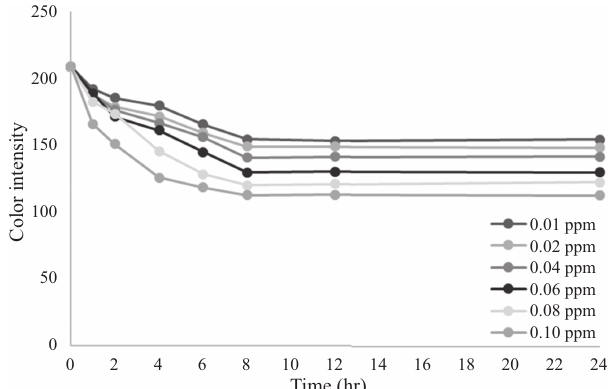
Figure 3. Color intensity and test duration obtained from each